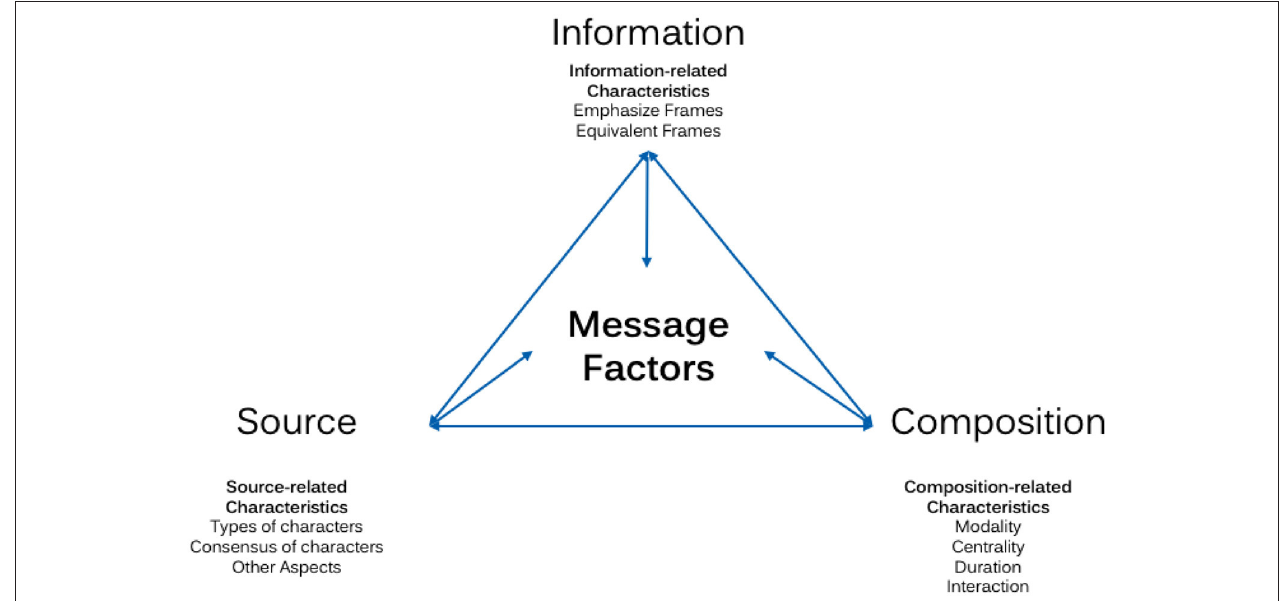
FIGURE 1 | Typology of persuasive